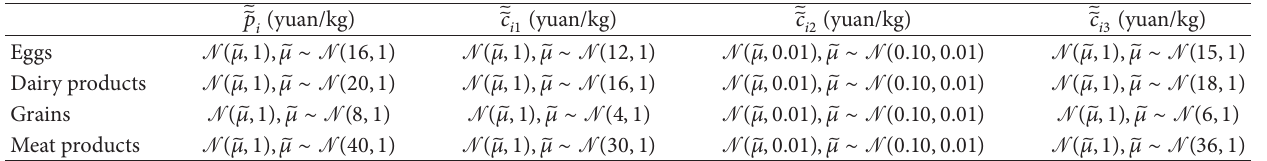
Table 2: Birandom variables.